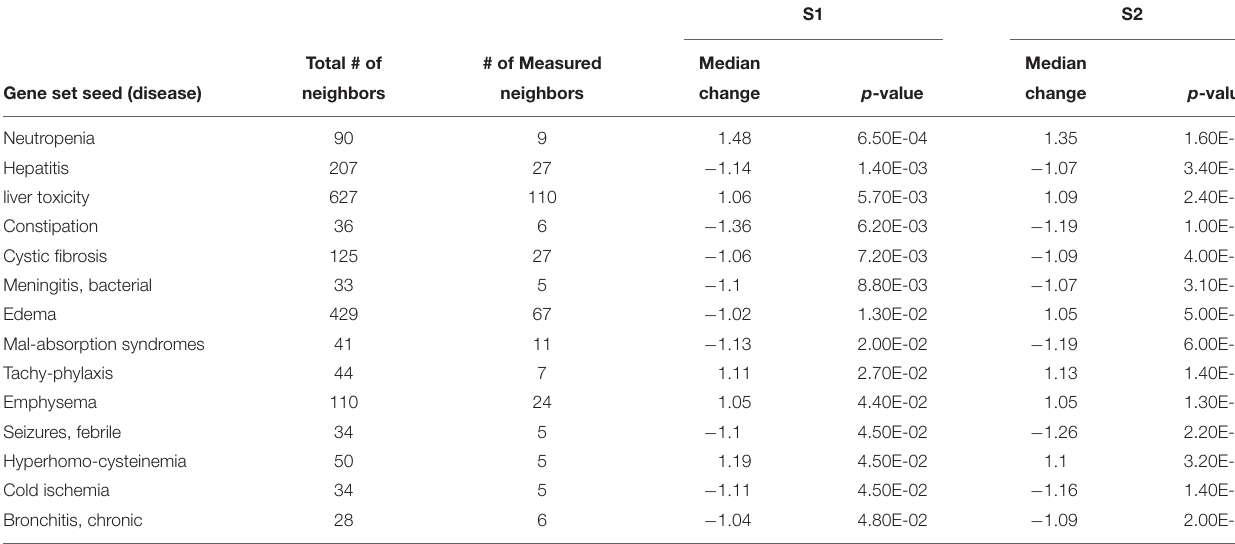
TABLE 4 | Sub-network enrichment analysis (SNEA) for diseases in S. tropicalis exposed to S1 and S2 mixtures of NAs. S1 S2 Total # of # of Measured Median